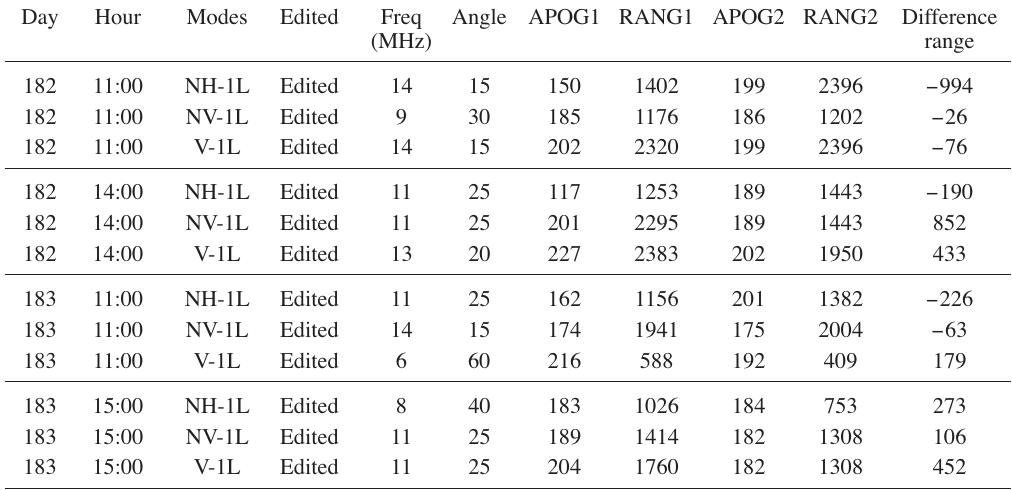
Table II. Maximum range differences for El Arenosillo link. Modes (NH = NHPC , 1L = POLAN 1 -layer , NV = POLAN no valle y, V = POLAN valley ). Manually scaled ionograms are indicated with the word ‘edited’. APOG1 and APOG2 are the apogee heights obtained with first and second option in column Modes and RANG1 and RANG2 their ranges.